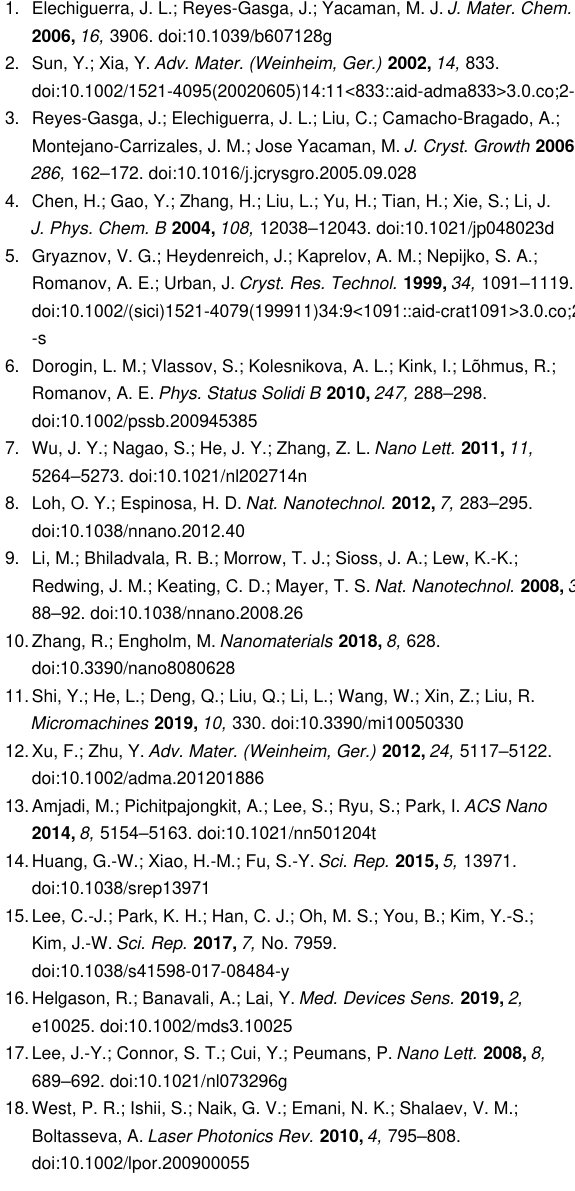
Figure 9: Bending of an alumina-coated silver NW. No breaking or abrupt deformation were observed even for relatively high bending curvatures.